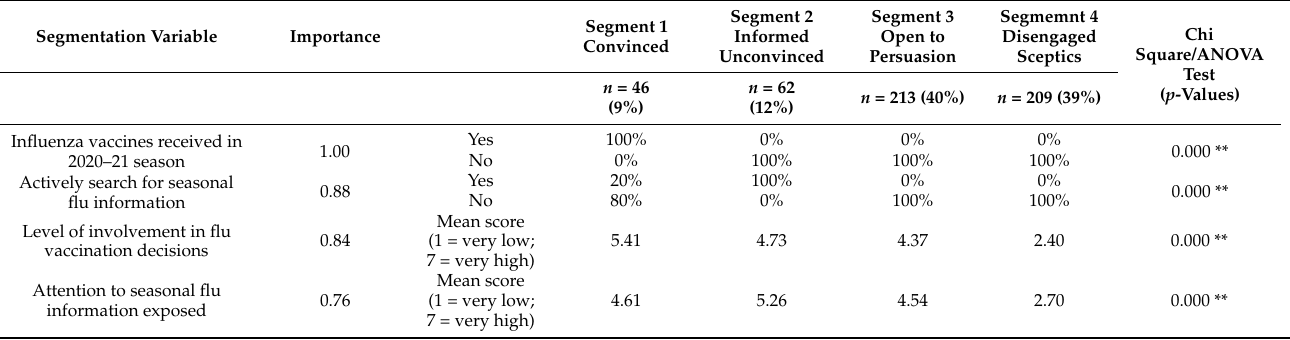
Table 2. Summary of two-step cluster analysis results ( n =